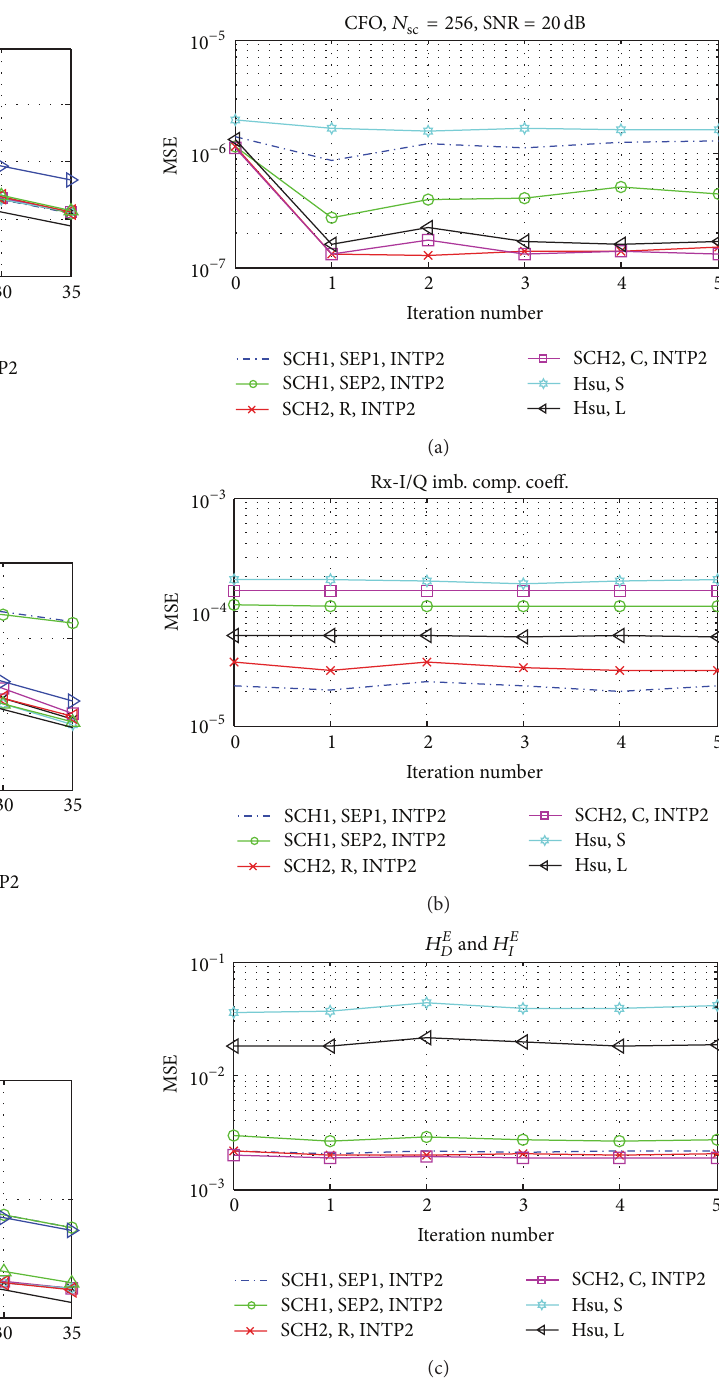
Figure 9: Estimation MSE as a function of iteration number, 𝑁 = 256, 𝜖 = 0.15 , and SNR = 20 dB.